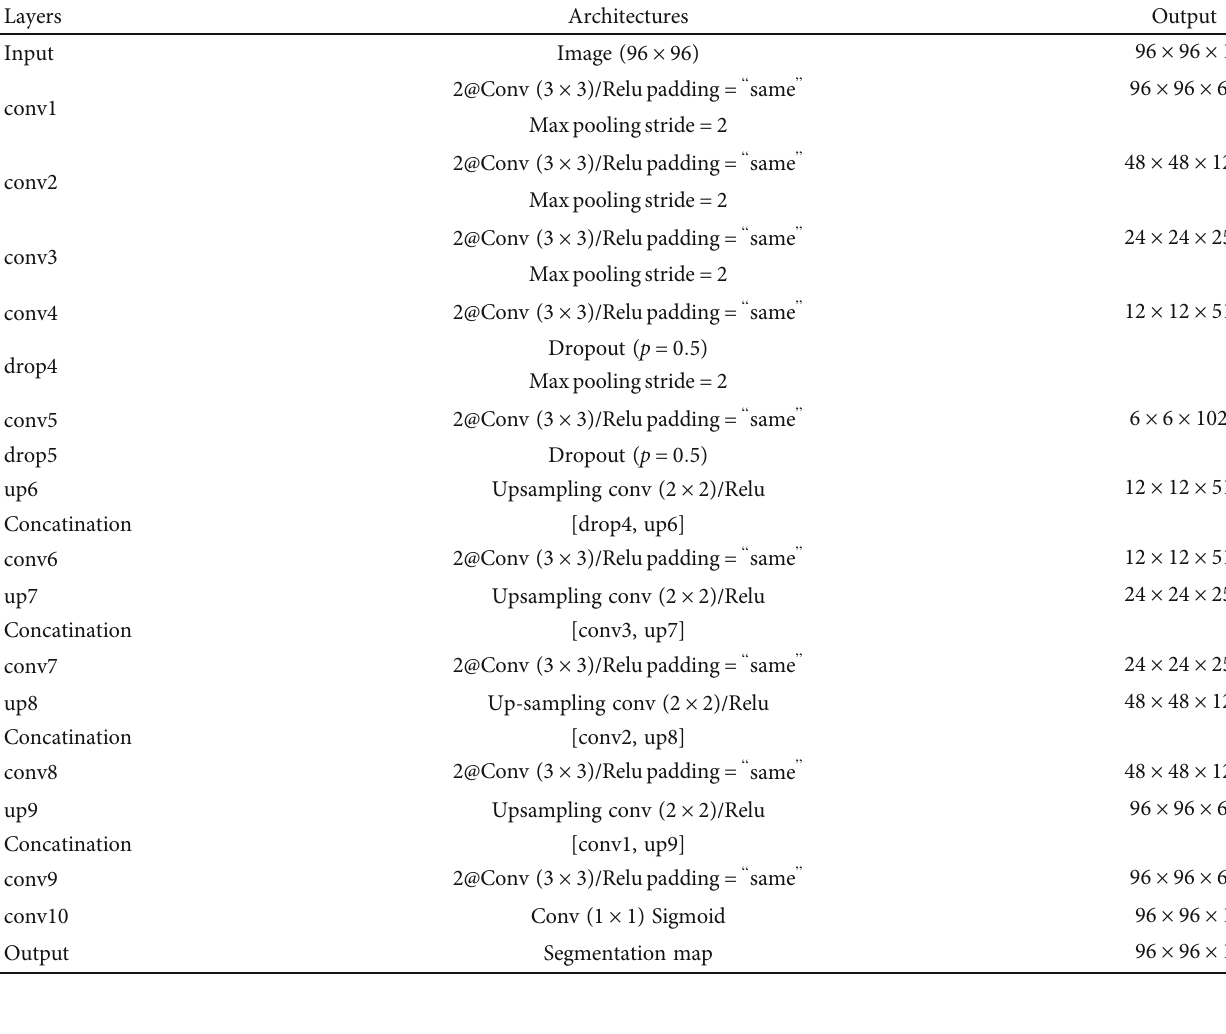
Table 2: Detail of the architecture of U-Net.